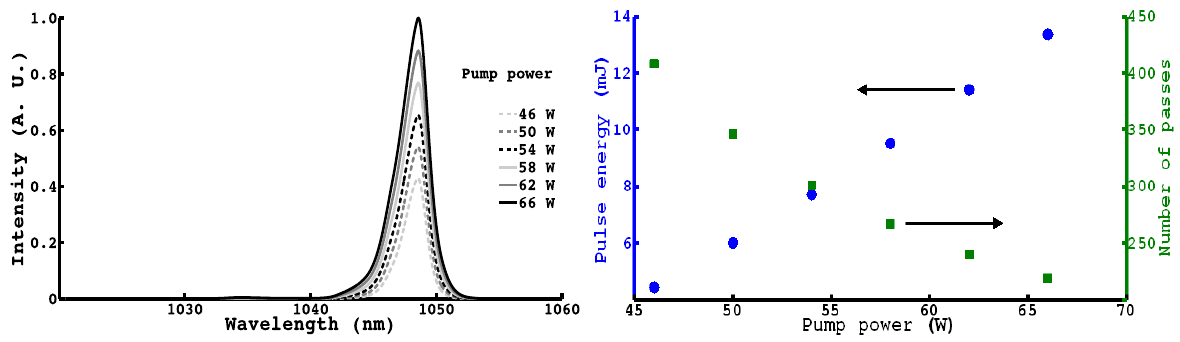
Figure 5. Simulation of regenerative amplification based in Yb:CaF Left : Output intensity vs . wavelength for a range of pump power; Right : output energy and required number of passes vs . pump